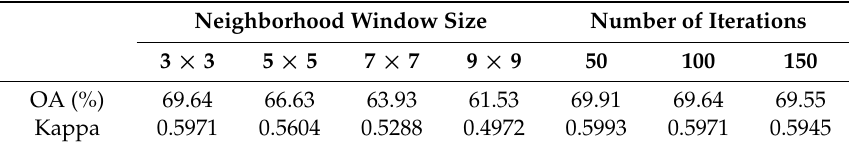
Table 7. The simulation accuracy of different neighborhood windows and a different number of iterations.